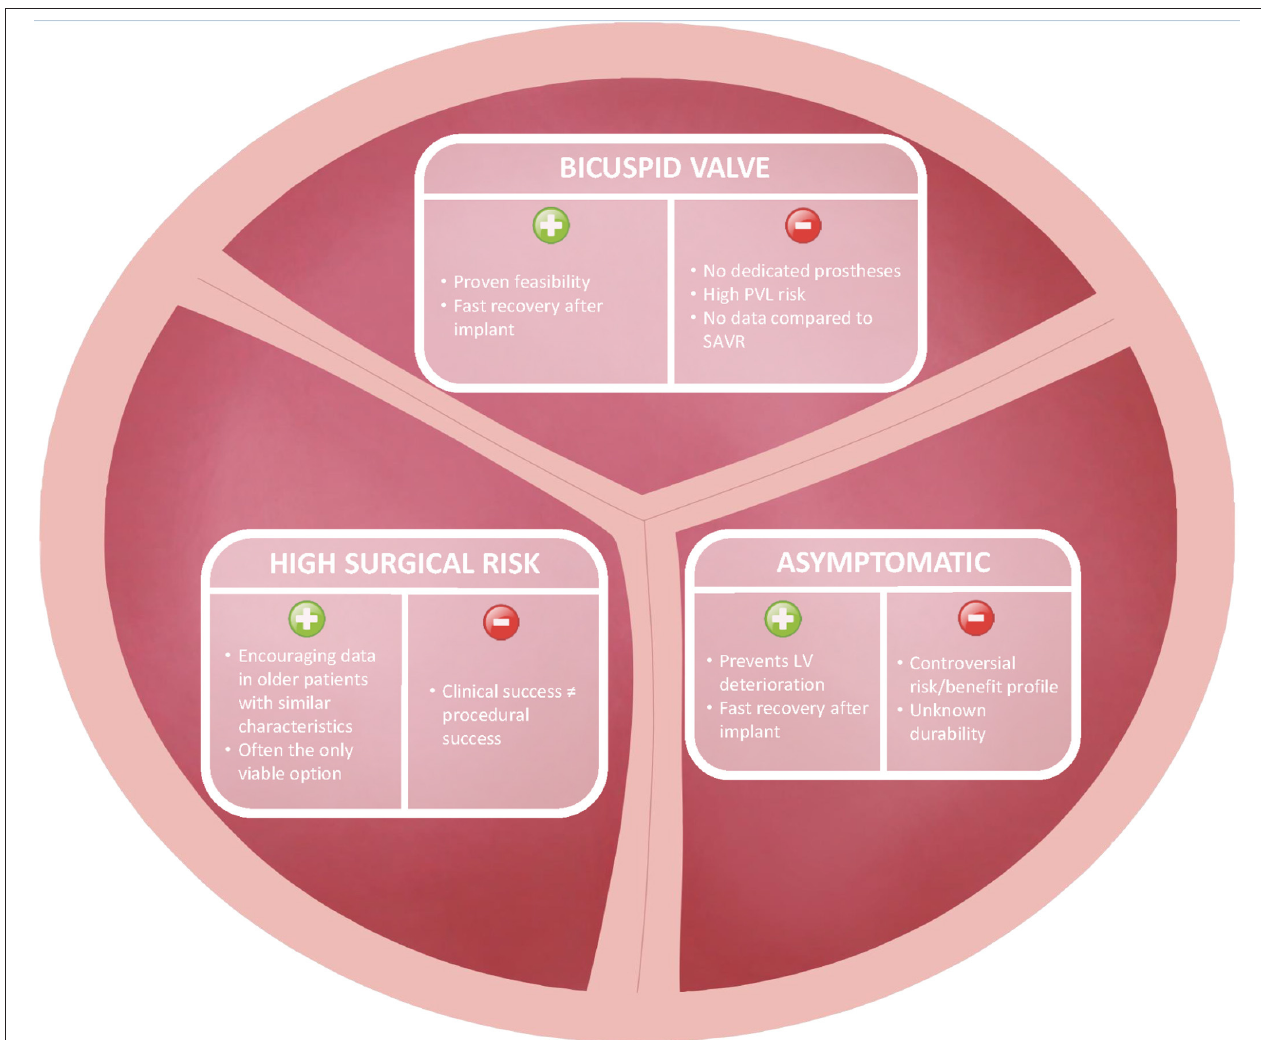
FIGURE 1 | Pros and cons of transcatheter aortic valve replacement in young patients.